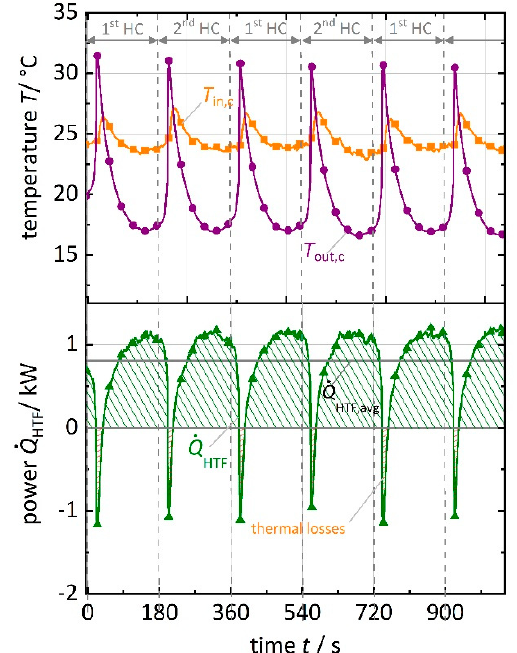
Figure 8. Top: transient course of the inlet and outlet temperatures of the cooling HTF loop. Bottom: transient course of the resulting cooling power.